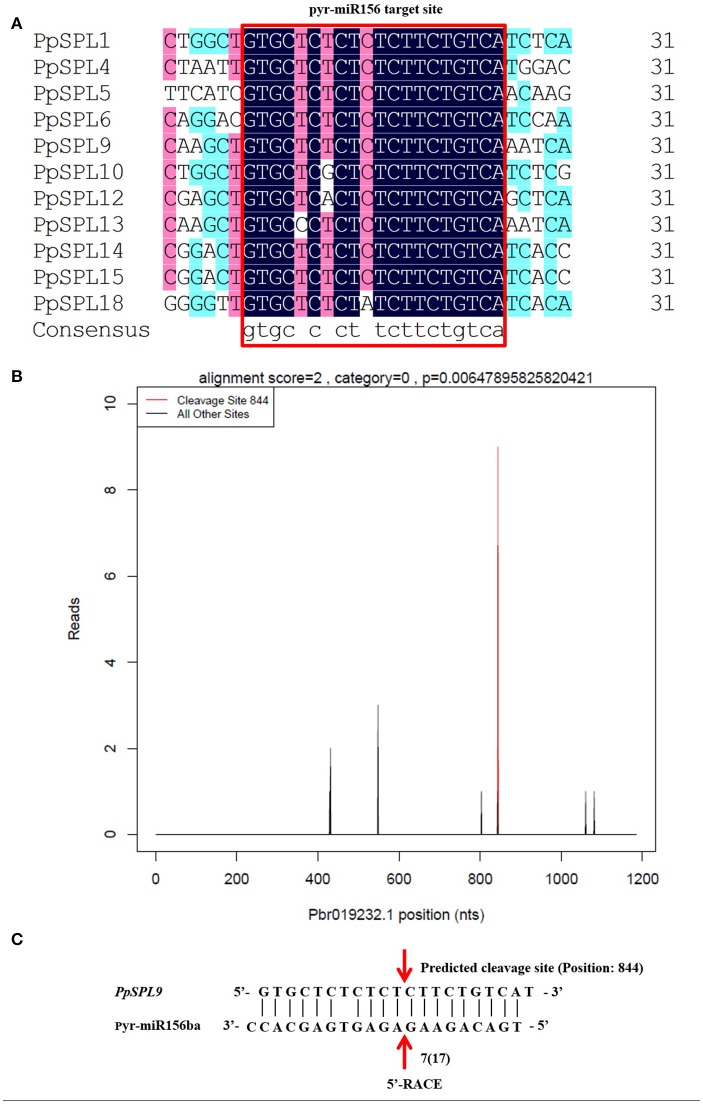
miR156 and its target PpSPL genes. (A) Alignment of multiple pyr-miR156 target site sequences from PpSPL genes using DNAMAN software. (B) T-plot indicating the cleavage events mediated by miR156ba in PpSPL9 based on degradome sequencing results. (C) Cleavage site mediated by miR156ba in PpSPL9. The cleavage events identified during degradome sequencing were verified by 5′-rapid amplification of cDNA ends (5′-RACE). 17 colonies were sequenced, and 7 of them corresponded to the cleavage site of position 844.